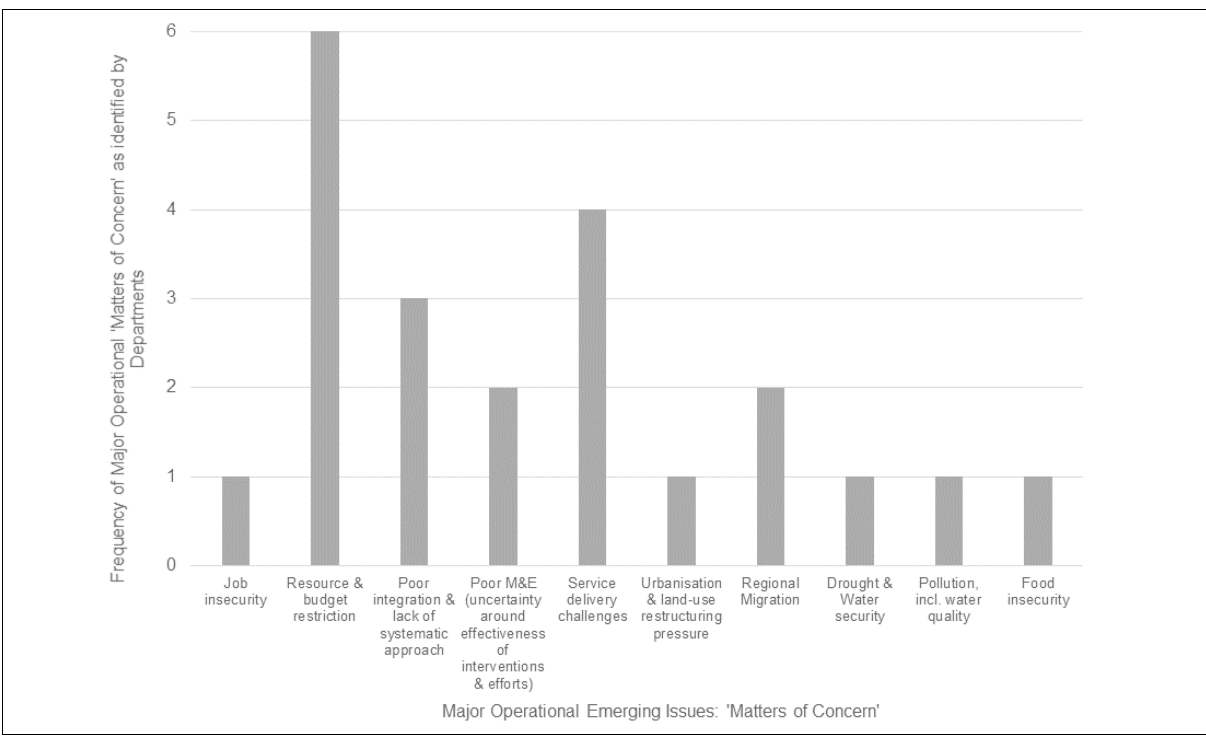
Figure 5: Emerging issues (‘matters of concern’) seen as major operational challenges in the City of Johannesburg’s (CoJ) day-to-day activities. Operational concerns were thematically coded from individual one-on-one and small group targeted interviews conducted with representatives of different CoJ Departments (City Parks, Environment and Infrastructure Services Department, Development Planning, Disaster Management, Johannesburg Water, Environmental Health Department, Johannesburg Road Agency). Frequency is the aggregated count of themes that emerged from interview data across all Departments.